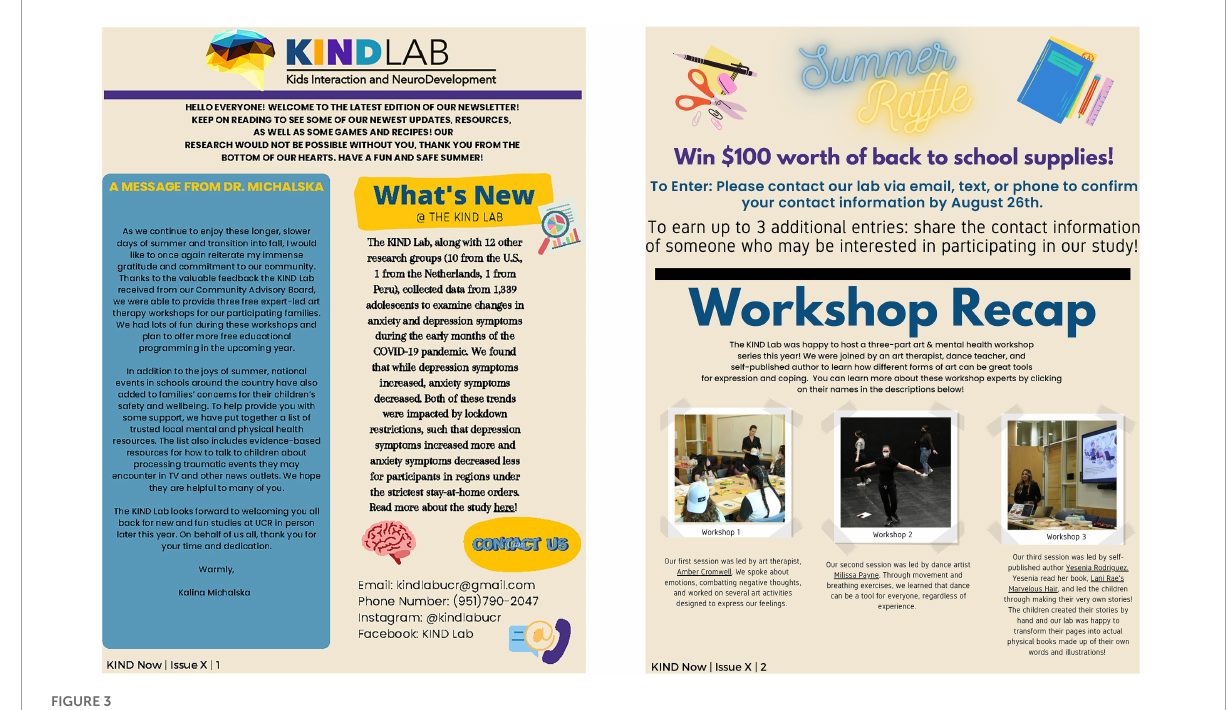
FIGURE3 Excerpted pages from our KIND Lab